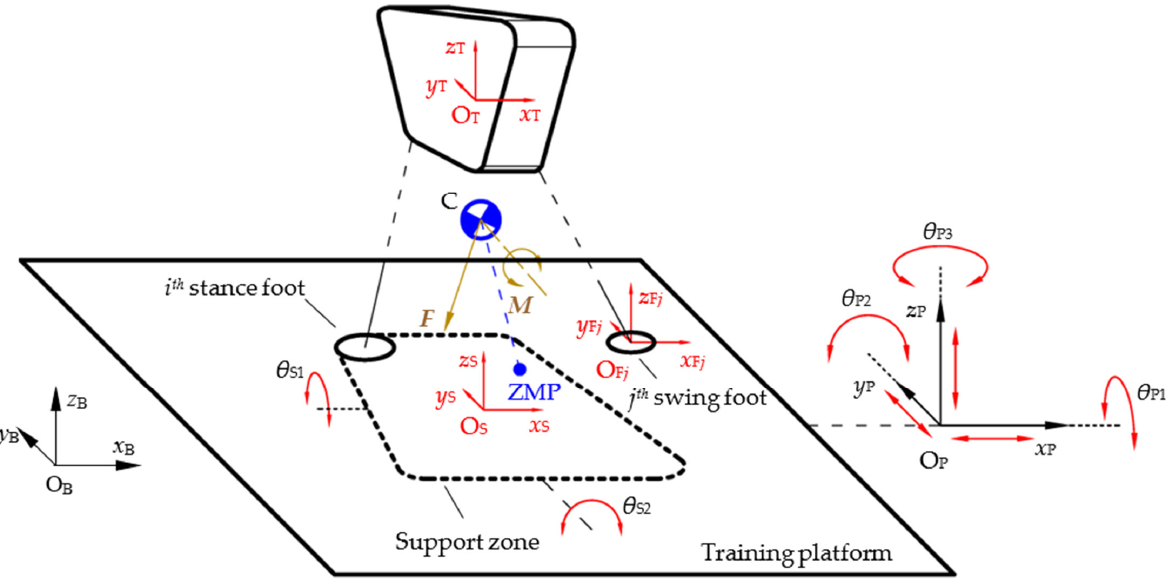
Figure 4. The general model for stability training system.